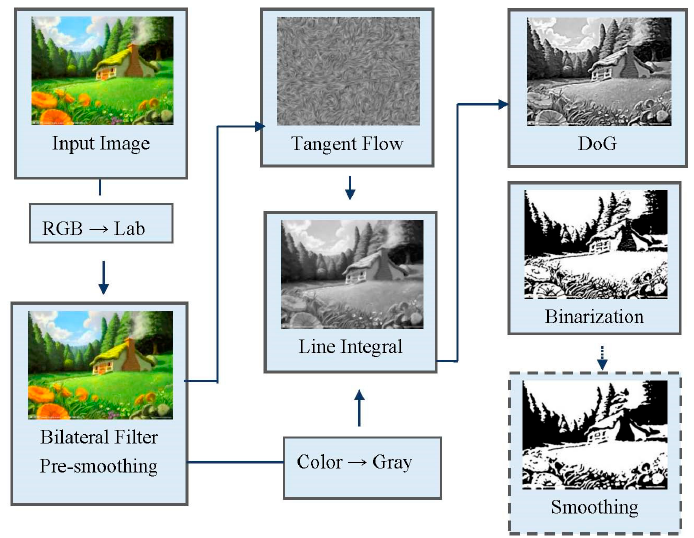
Figure 4. Framework overview. Each step of our framework, along with the performed function